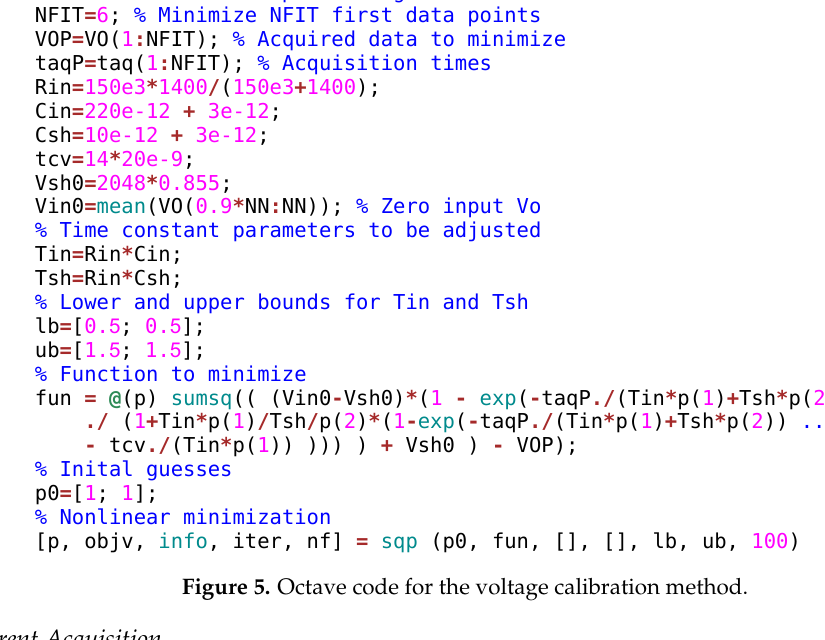
Figure 5. Octave code for the voltage calibration method.